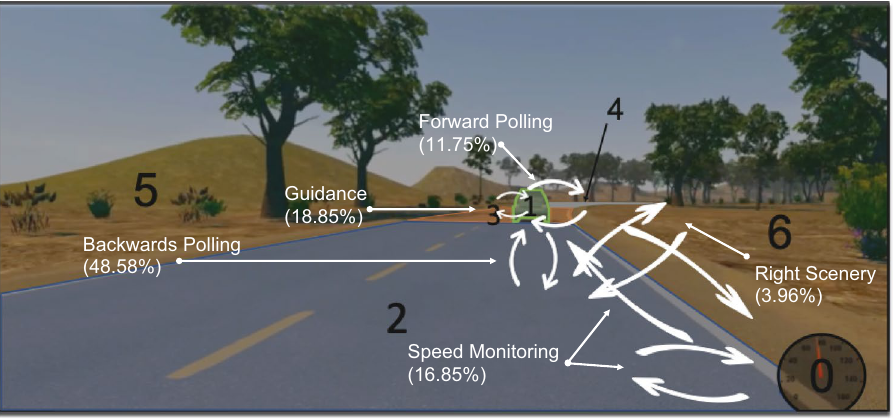
Figure 4 . Representation of the main visual sequences identified under Manual Driving (and associated relative frequencies in percentage). Photograph JN.